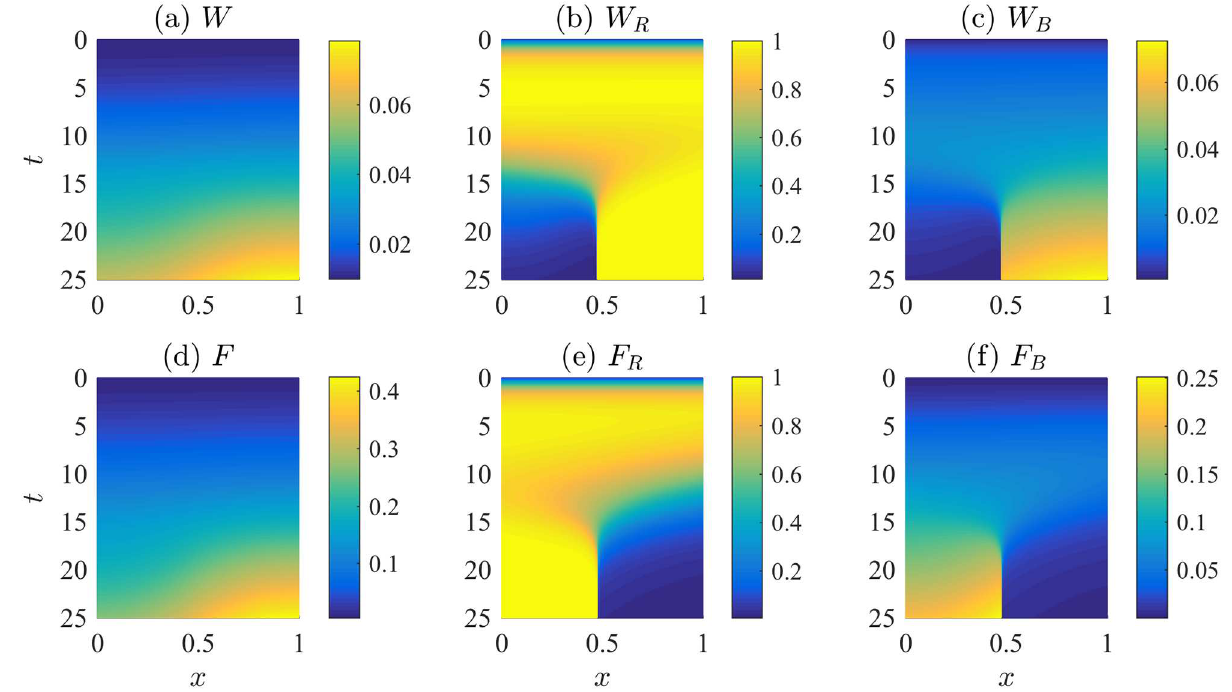
Fig 5. The Wnt-FGF mutual inhibition model predicts the formation of signalling domains in response to graded W 1 across the primordium. Simulation kymographsfor Wnt and FGF signalling. Initially, we assumed a gradient W 1 ( x ) = bx + 0.03 in the uncoupled Wnt steady state parameter, with b = 0.01. Time increasesdownwards; positionacross the PLLP is horizontal,with leadingedge on the right. (a) Wnt ligand, W ( x , t ), (b) Wnt receptors, W R ( x , t ), (c) boundWnt receptors, W B ( x , t ), (d) FGF ligand, F ( x , t ), (e) FGF receptors, F R ( x , t ), and (f) bound FGF receptors, F B ( x , t ). Signallingdomainsform after a few minutes, with a sharp boundarybetweenzones. Bound ligand concentrations are calculatedusing Eq (3). Parameters are as in Table A in SupportingInformation S6 Text. Parameter Estimation and Values. Initial conditions: W ( x , 0) = 0.01, F ( x , 0) = 0.005, W R ( x , 0) = 0.1, F R ( x , 0) =